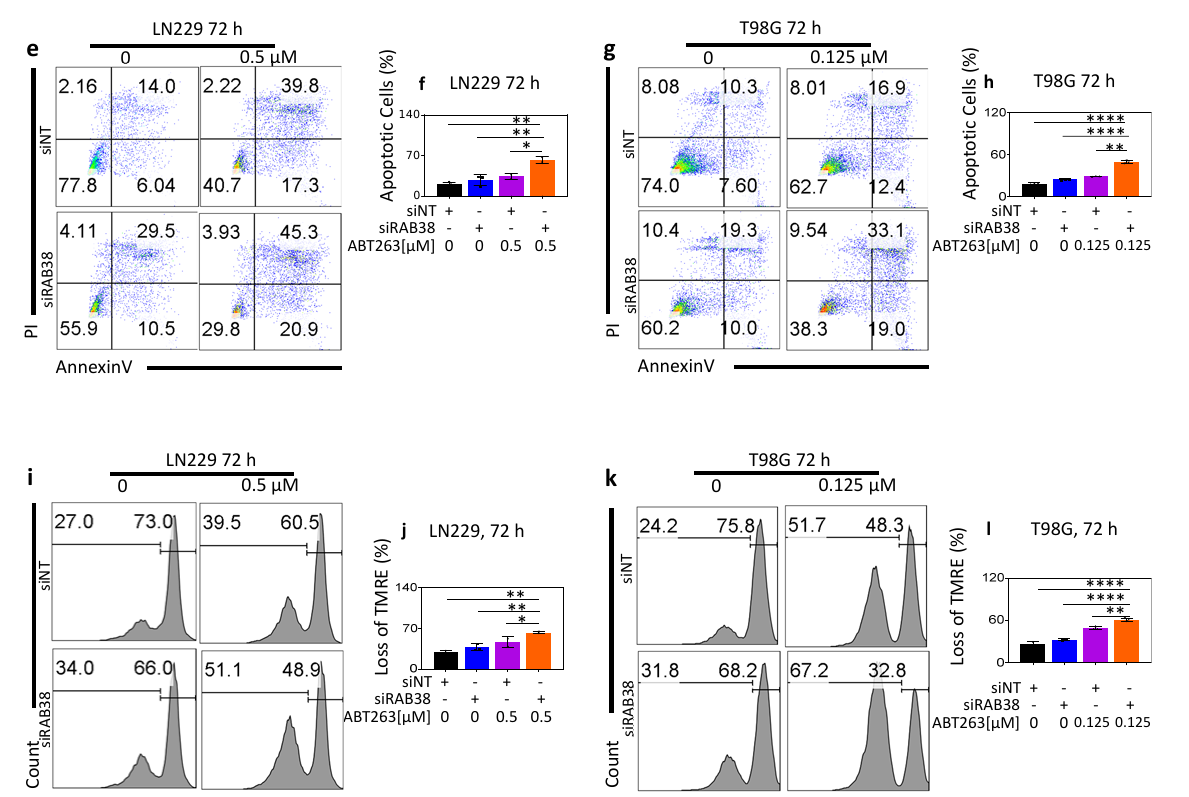
Figure 5. RAB38 knockdown renders glioblastoma cells vulnerable to a BH3-mimetic drug enhancing cell death in vitro. ( a – c ) LN229 ( a ), T98G ( b ), and GBM43 ( c ) cells were transfected with nontargeting (NT) siRNA or RAB38 siRNA. Thereafter, cells were incubated with vehicle or ABT263, for 72 h. ABT263 was used at four different concentrations. Cellular viability was determined by CellTiter-Glo assay and relative cell viability was calculated. Data are presented as mean and SD, n = 3. ( d ) Bliss analysis was performed in order to understand whether RAB38 silencing and ABT263 had a synergistic effect on the reduction in cellular viability. ( e – h ) LN229 ( e ) and T98G ( f ) glioblastoma cell lines were transfected with either siNT or RAB38 siRNA. Thereafter, transfected cells were treated with vehicle or ABT263, stained with annexin V/propidium iodide 72 h after silencing, and then analyzed by flow cytometry. Representative plots and a histogram with statistical analysis are presented ( n = 3). ( i – l ) LN229 ( c ) and T98G ( d ) cells were transfected with either siNT or siRAB38 siRNA and treated with vehicle or ABT263. Seventy-two hours after transfection, cells were labeled with TMRE and analyzed by flow cytometry. Representative plots and a histogram with statistical analysis are presented ( n = 3). * p < 0.05; ** p < 0.01; ***/**** p < 0.001, n.s. means not